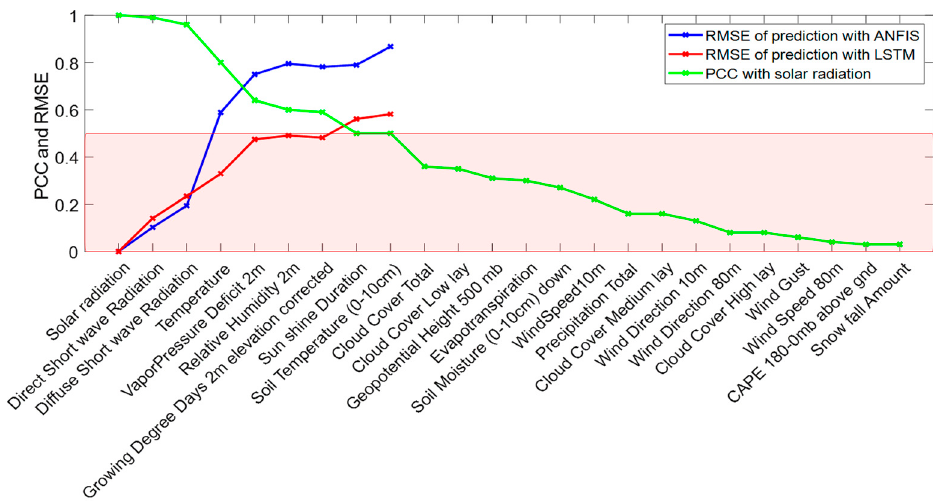
Figure 8. Meteorological parameters’ ranking based on Pearson Correlation Coefficients and Comparative performance of LSTM and ANFIS models with significant parameters selection (PCC value ≥ 0.5) (employed dataset from 1 January 2017, until 22 August 2021).